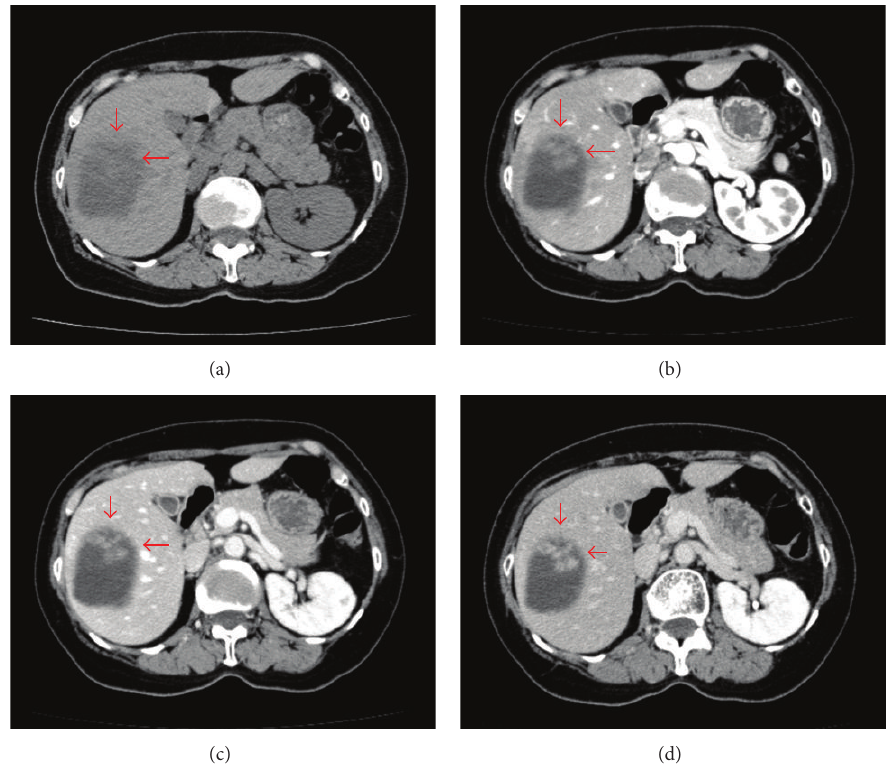
Figure 3: Dynamic contrast-enhanced computed tomography performed in February 2012. (a) Simple, (b) early phase, (c) portal phase, and (d) parallel phase images. The cystic mass occupying the right hepatic lobe was approximately 9.8 × 7.7 × 9.1cm in size and had slightly increased in size since September 2011. Solid components exhibiting increased contrast uptake are observed at the base and left walls of the cyst